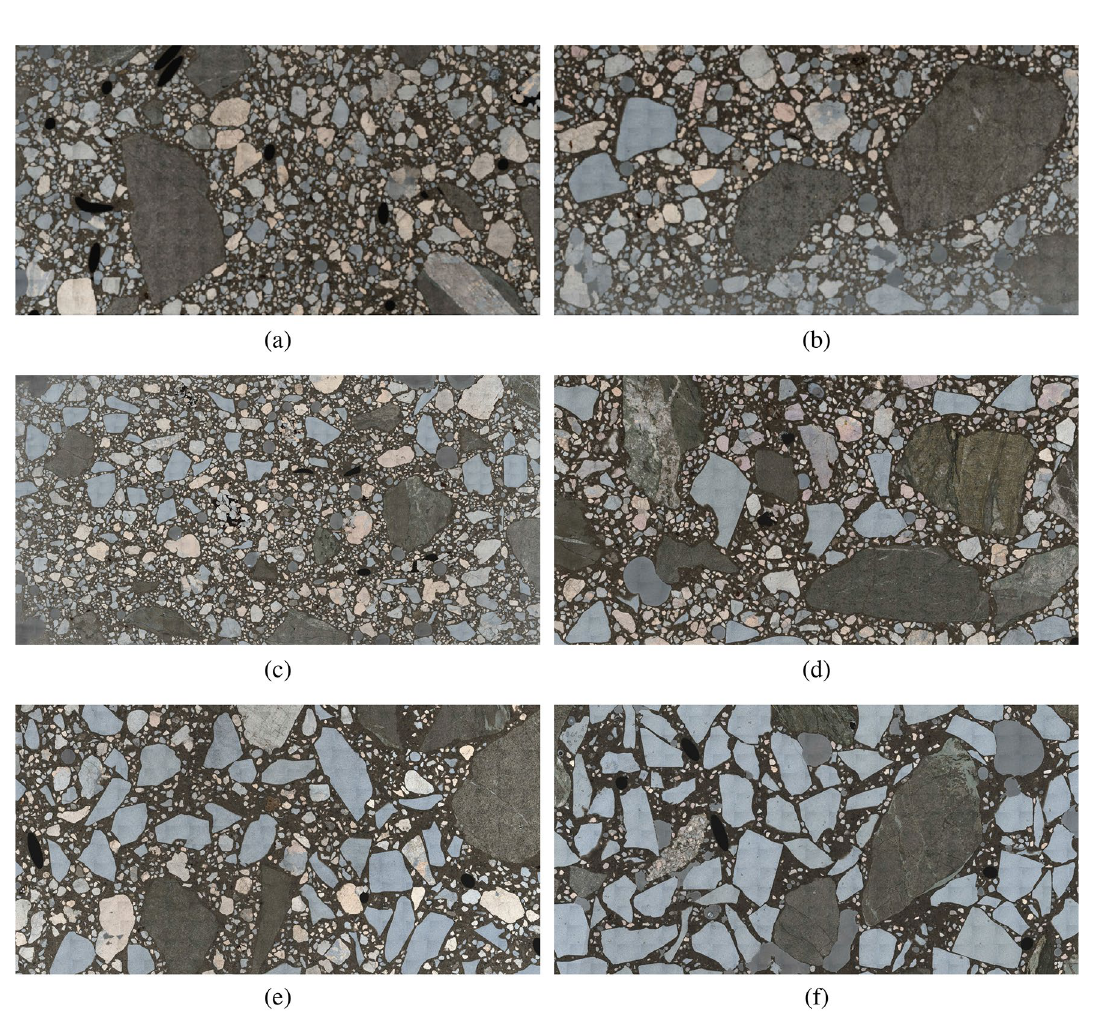
Fig. 5 Analysis of thin sections obtained from shotcrete mixes with 0%, 10%, 15%, 20%, 50% and 100% sand replaced with glass aggregates from ( a ) to ( f ),